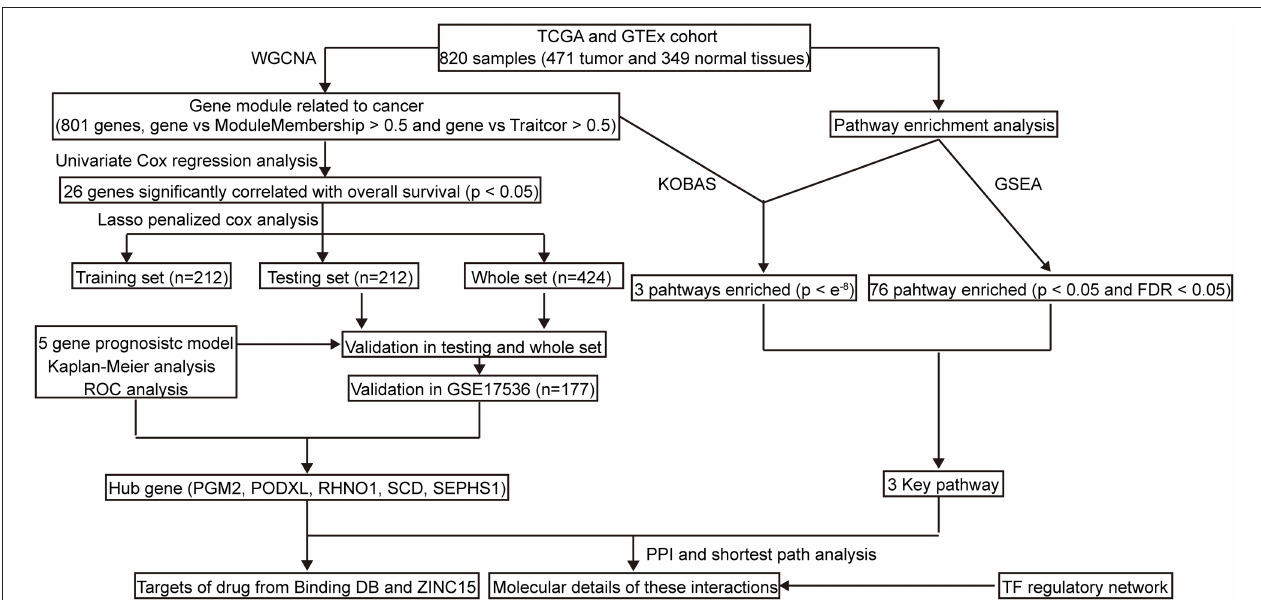
FIGURE 1 | The workflow of the study. TCGA, The Cancer Genome Atlas; GEO, Gene Expression Omnibus; GTEx, Genotype-Tissue Expression; KEGG, Kyto Encyclopedia of Genes and Genomes; WGCNA, Weighted correlation network analysis; GSEA, Gene Set Enrichment Analysis; PPI, Protein-protein interaction; ROC, Receiver operating characteristic; TF, Transcription